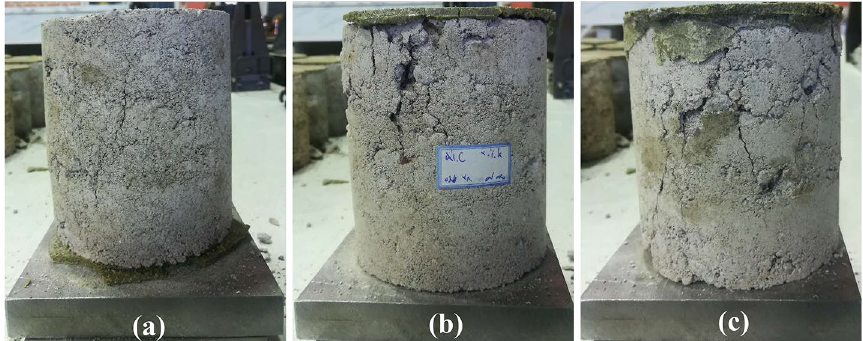
Fig. 16 The failure mode of CSG mixtures with 5% cement, cured at age 28 day and containing: a 10% kaolinite (S-C5-K10 sample), b 20% kaolinite (S-C5-K20 sample), c 30% kaolinite (S-C5-K30